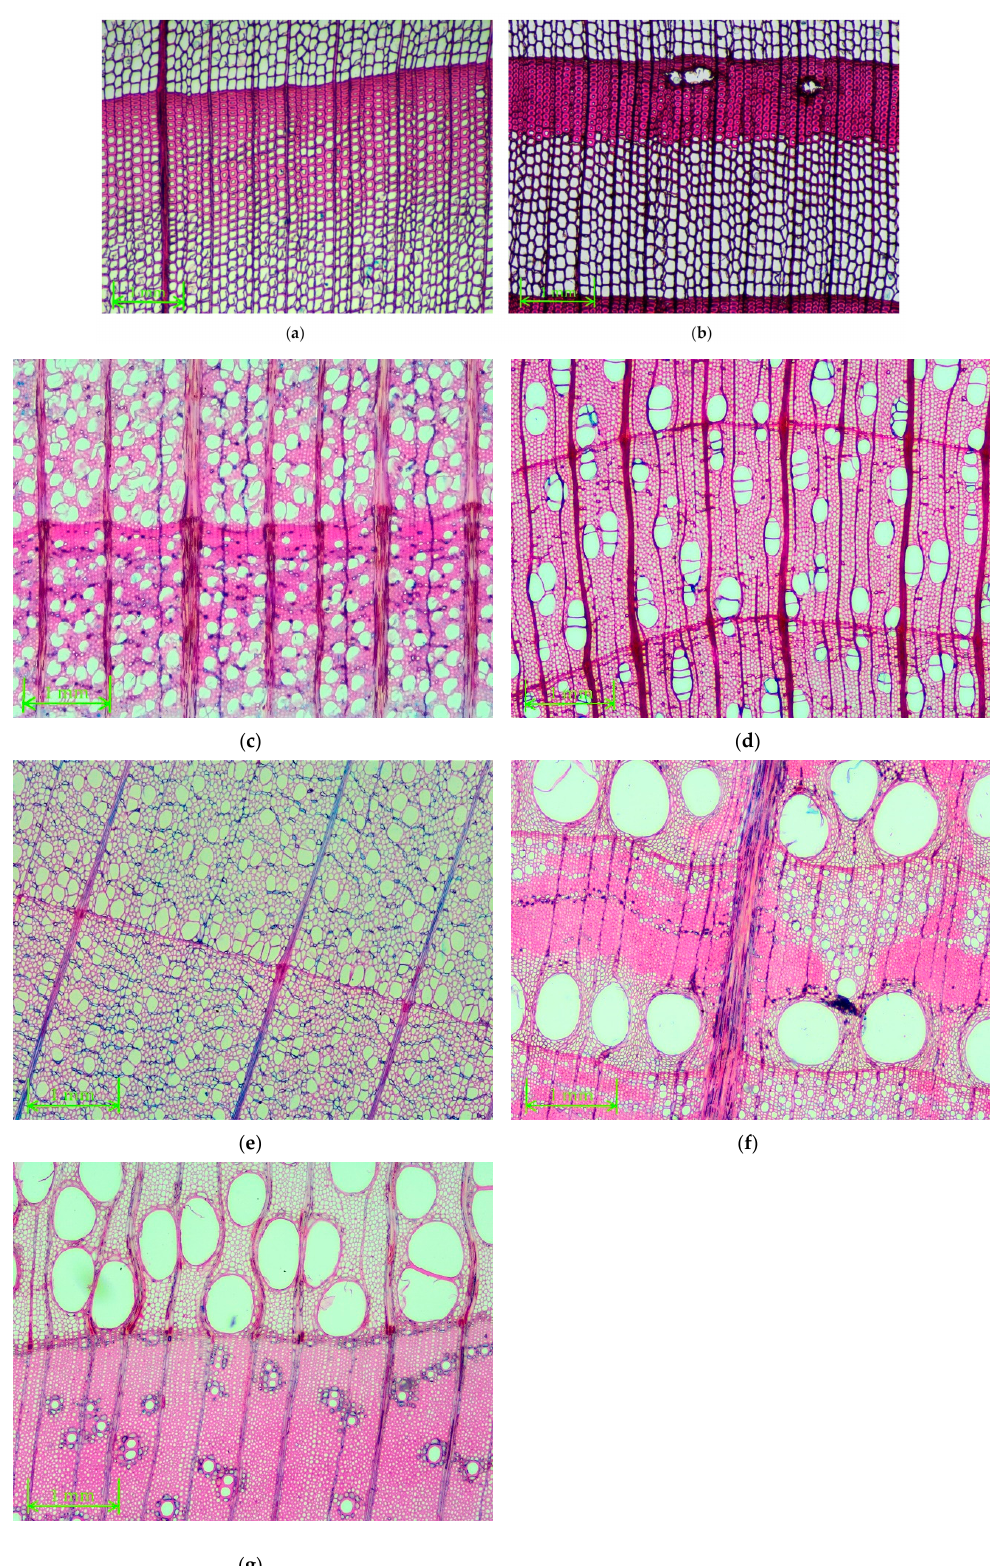
Figure 5. Cross section of wood at 40 × magnification: spruce ( a ), larch ( b ), beech ( c ), birch ( d ), linden ( e ), oak ( f ) and ash ( g ).